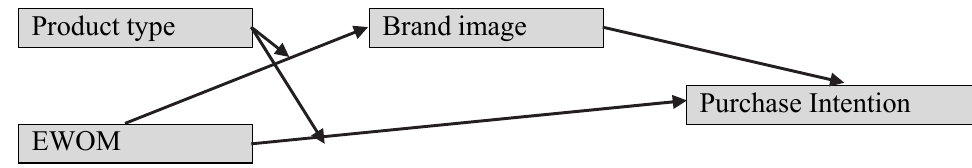
Fig. 1. The structure of the proposed